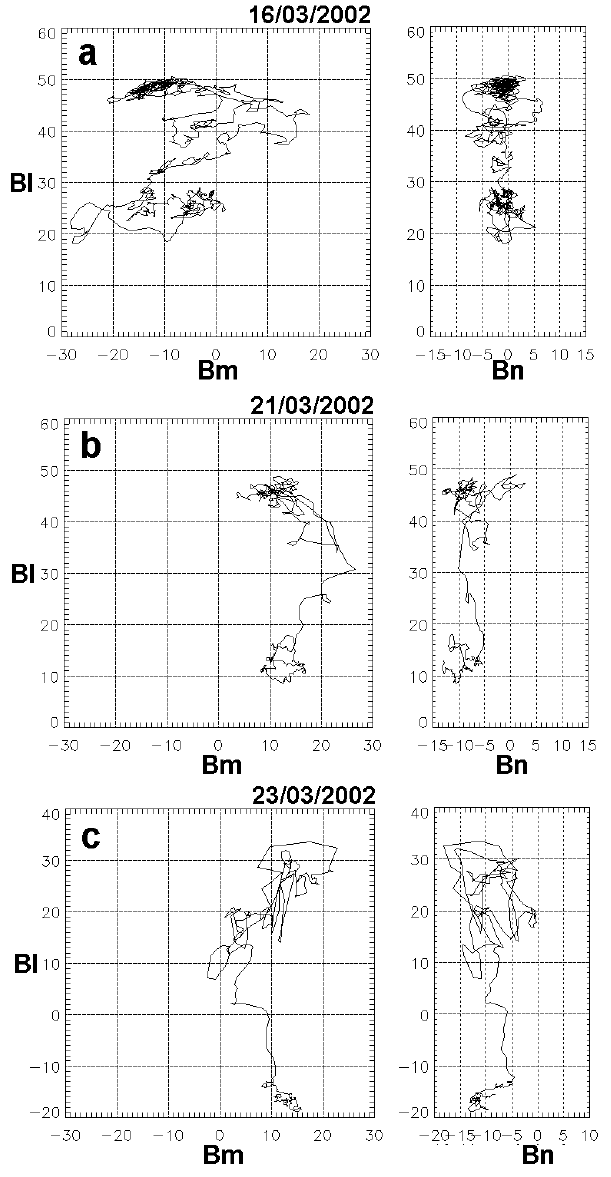
Figure 5. Magnetic hodograms of the exterior cusp-magnetosheath boundary for all three events. The LMN coordinates directly arise from the Minimum Variance Analysis (MVA).